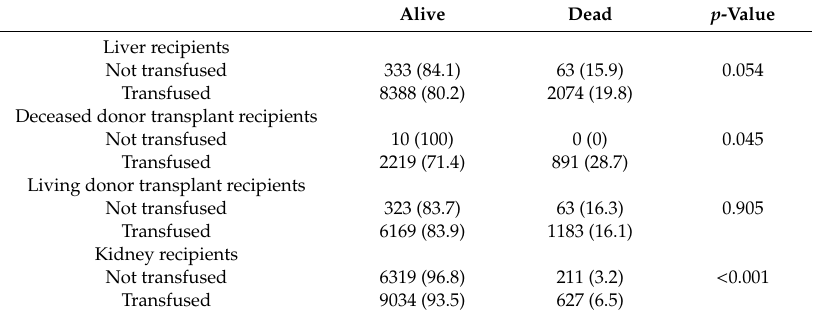
Table 4. Associations between transfusion and mortality among liver and kidney recipients. Alive Dead p